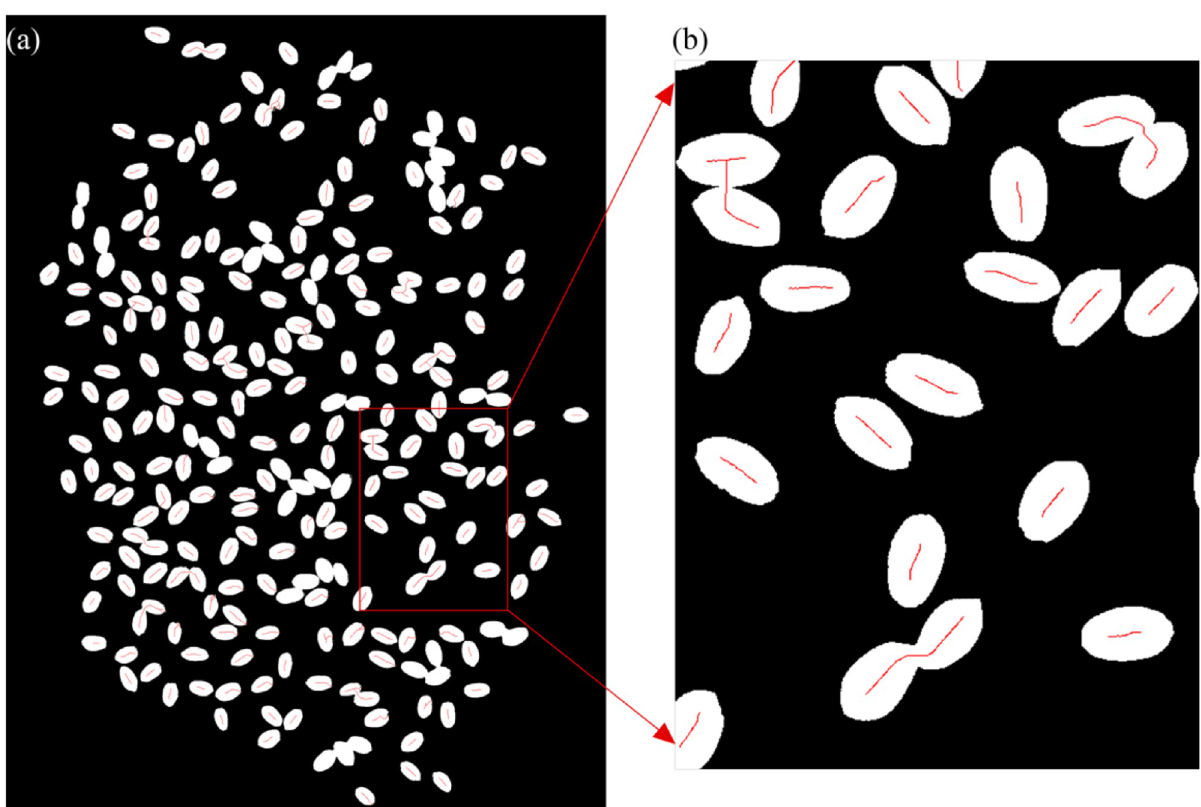
Fig 3. Grain skeleton of wheat. a: Grain skeleton graphics. b: Partially enlarged